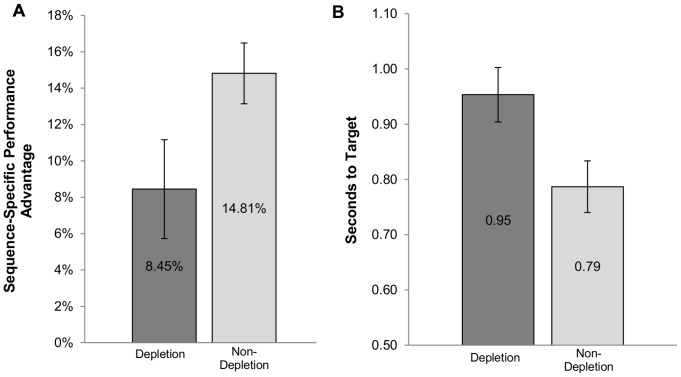
SISL test performance and speed for Experiment 1.The sequence specific performance advantage measures the improvement in SISL task execution when the cues are following the trained repeating sequence (calculated as the difference in percent correct for the trained sequence minus percent correct during untrained sequences of cues). (A) The Depletion group in Experiment 1 completed an ego-depleting task prior to training on the sequence. Less sequence-specific knowledge was expressed by the Depletion group at test. (B) Participants in the Depletion condition were also performing the task at test at a significantly slower rate at test than participants who had not been depleted (a higher number indicates the cues were taking longer to reach the target). The error bars reflect the standard error of the mean (SEM).